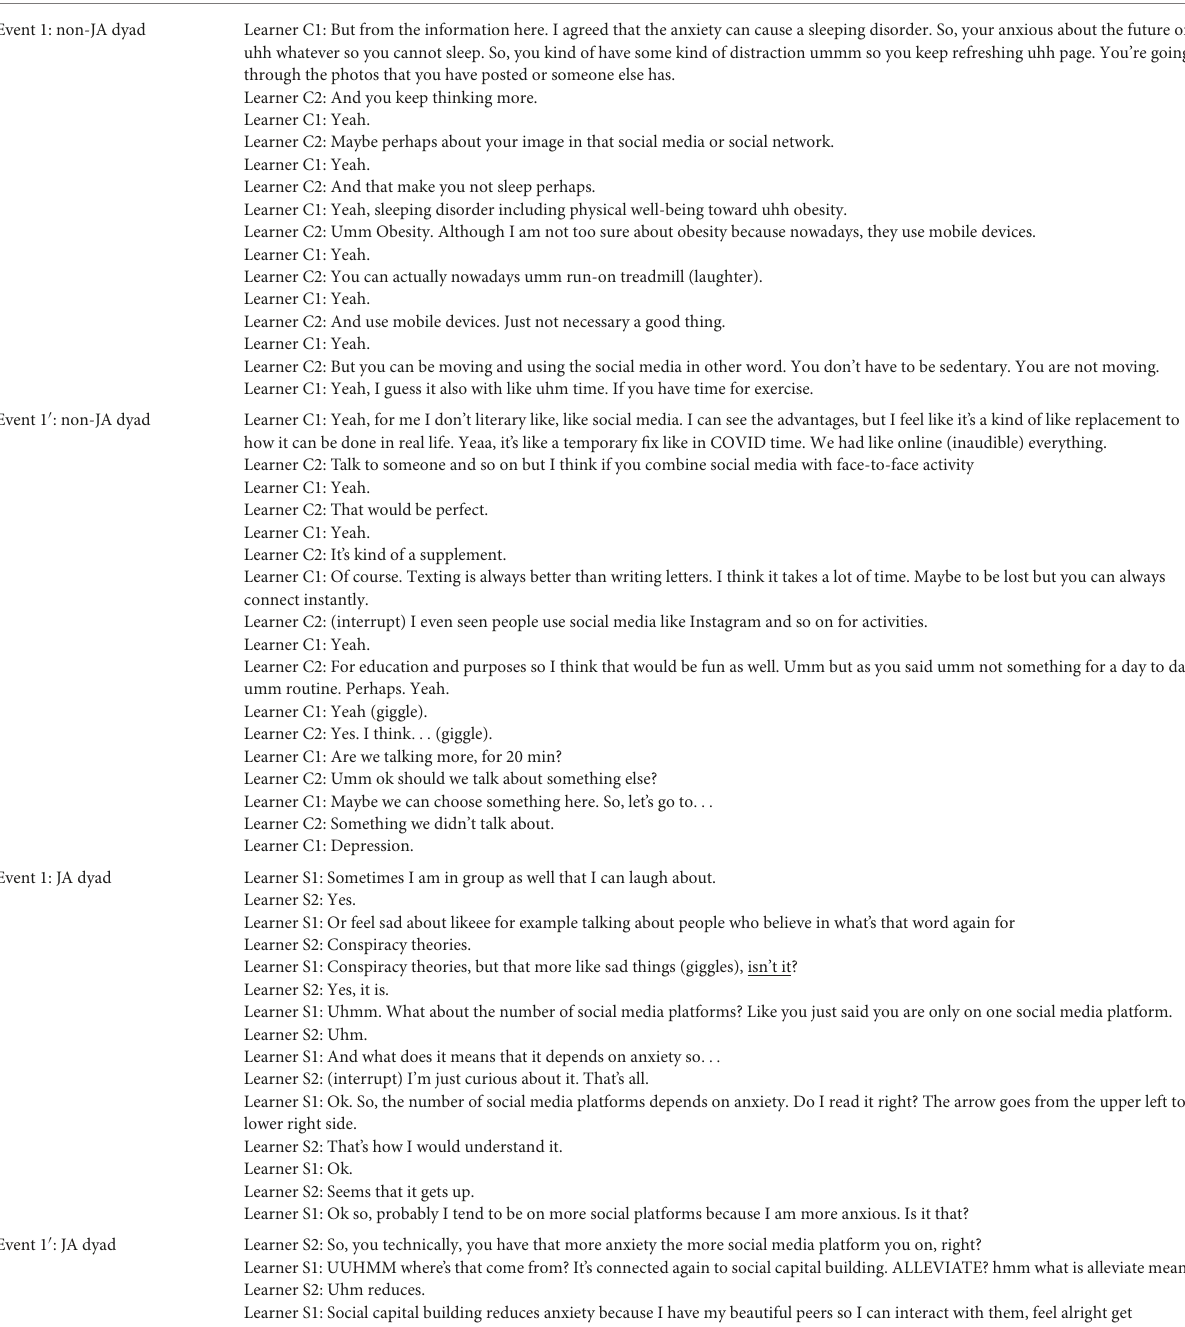
TABLE 1 The collaborative discourse in critical EDA events of a non-JA dyad (noted with letter C) and JA dyad (noted with letter S). Event